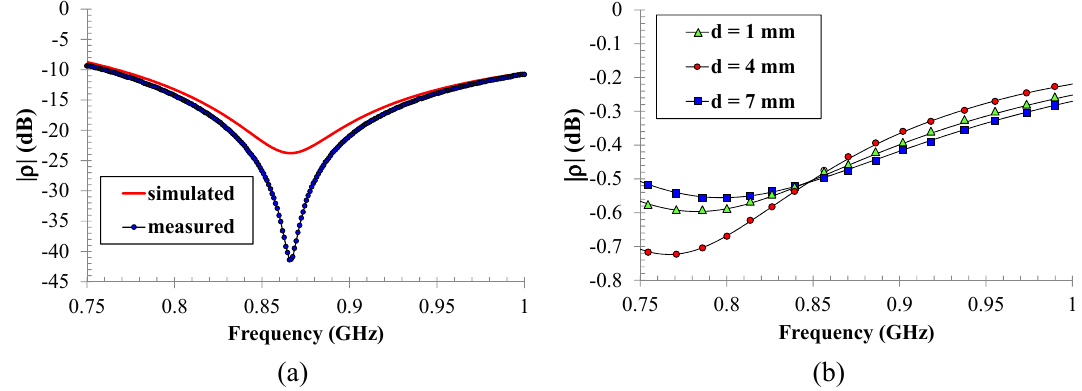
Figure 11. ( a ) Measured and simulated reflection coefficient at the magneto-dielectric (MD)-antenna port. ( b ) Reflection coefficient of an only-dielectric (OD)-antenna with an identical refractive index, by varying the coaxial cable position.